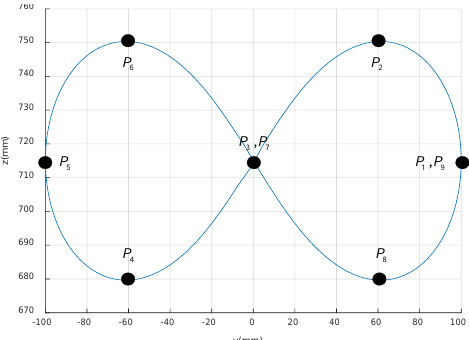
Figure 9. Critical point distribution. Table 2. Coordinate information of every critical point Coordinate in Cartesian Space (mm,deg)